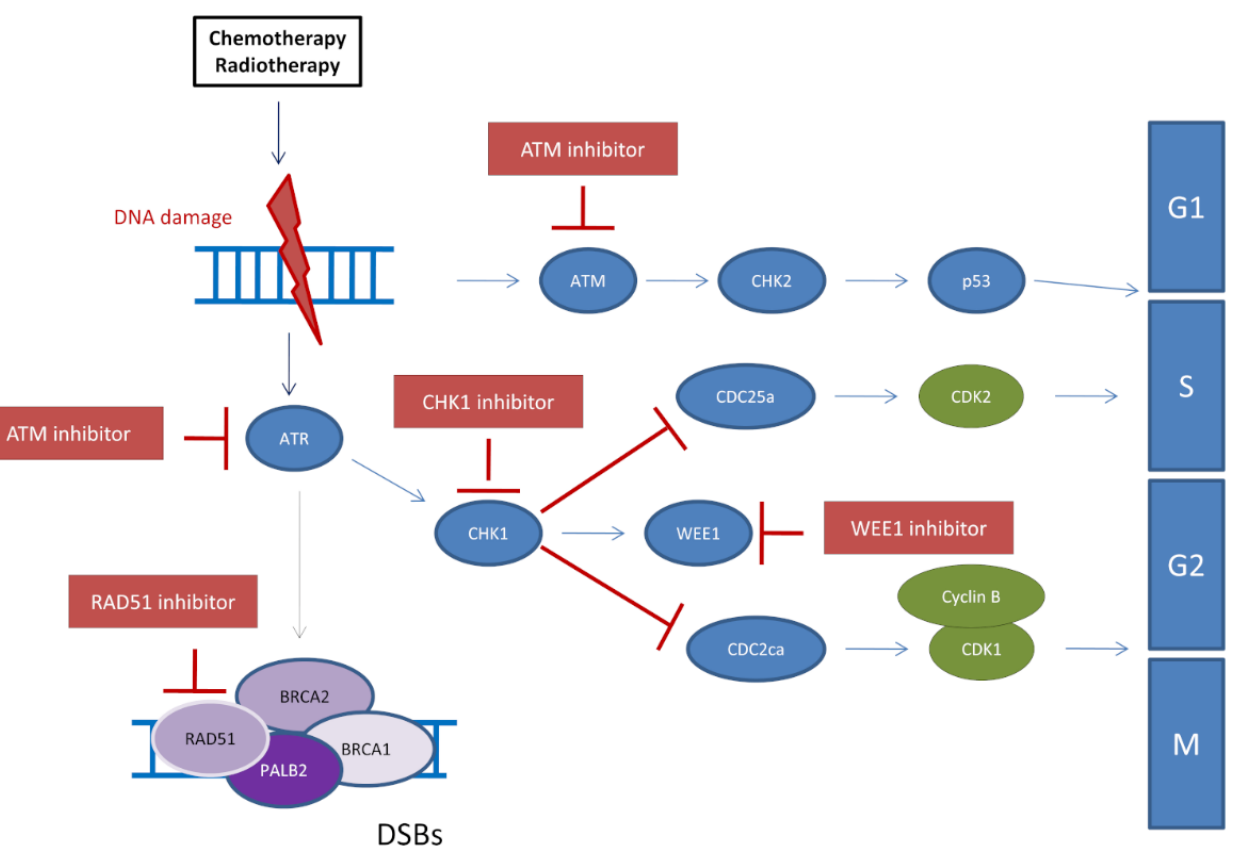
Figure 2. Therapeutic strategies to target DDR. Abbreviation: DSBs = Double-strand breaks.